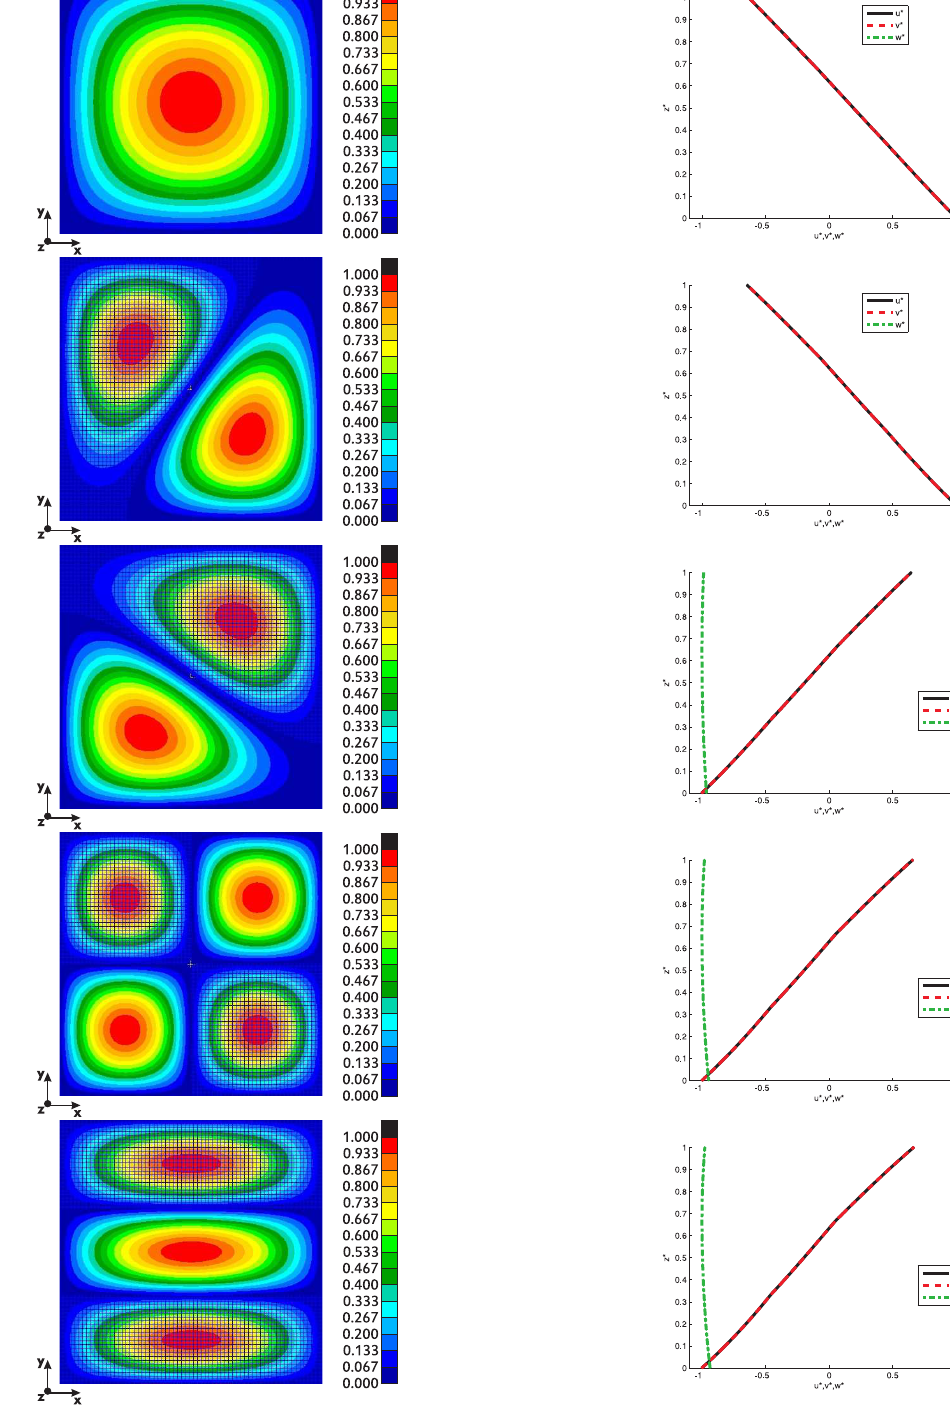
Figure 12: Fifth benchmark, simply supported plate made of aluminium alloy, titanium alloy and steel with thickness ratio a/h=10. First five frequencies (with transverse displacement w ≠ 0) via 2D FE solution (on the left) and via 3D exact solution (on the right).